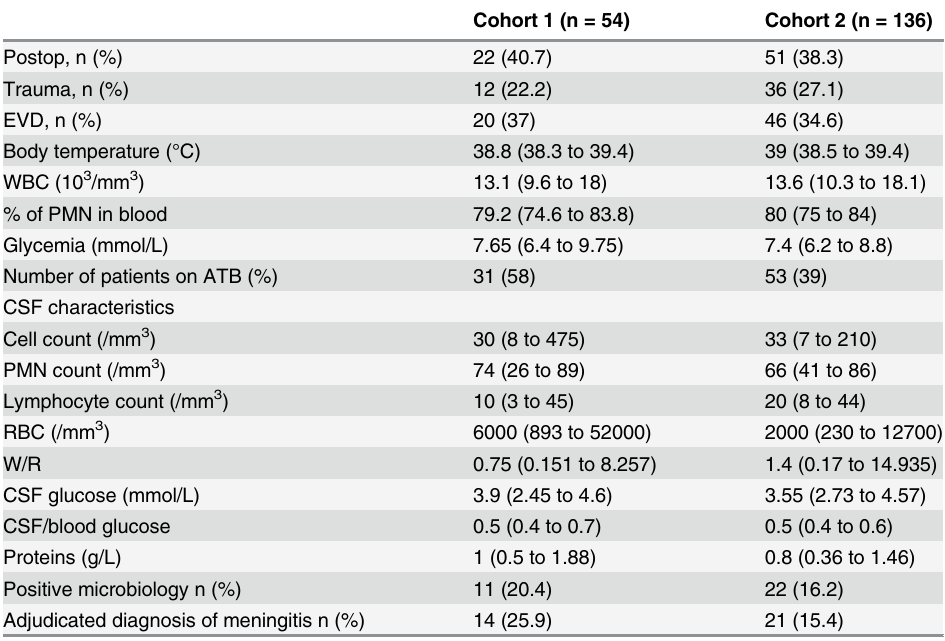
Table 1. Clinical context and characteristics of the two